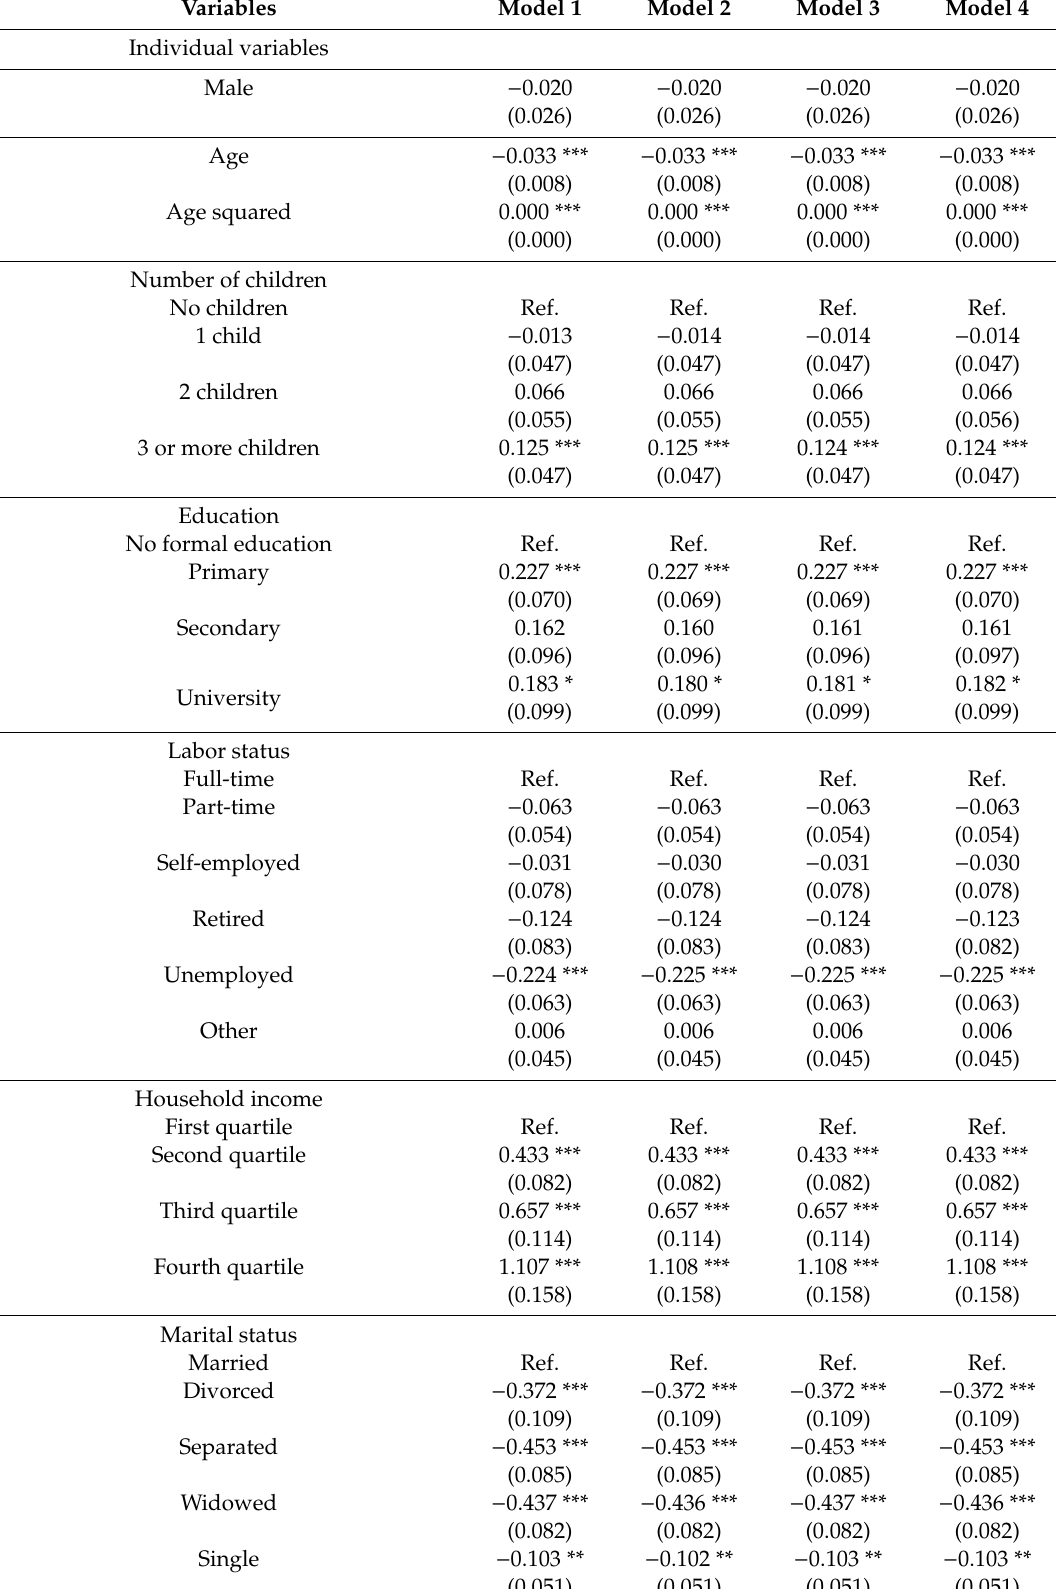
Table A6. Determinants of life satisfaction without variables of social trust and social